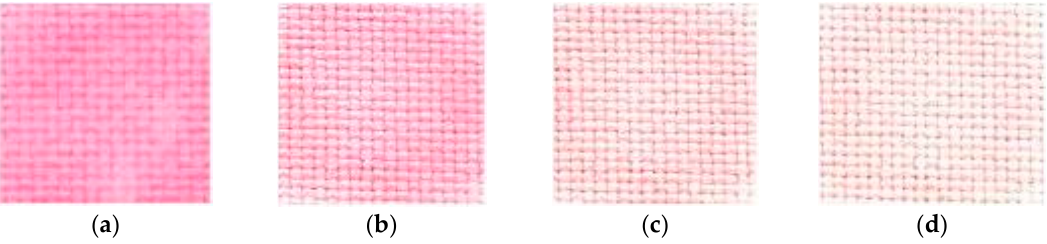
Figure 2. TiO 2 -modified polyester fabric with an eosin drop: ( a ) without UV-radiation; ( b ) after 20-min exposure to UV-radiation; ( c ) after 40-min exposure to UV-radiation; ( d ) after 60-min exposure to UV-radiation.